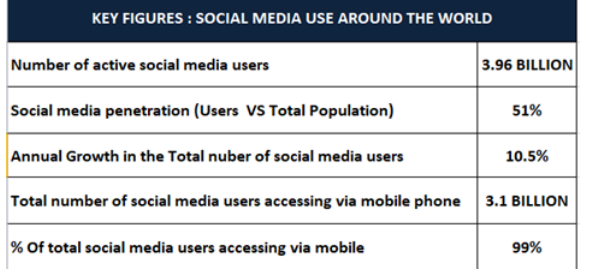
Figure 2: Social Media use around the world. Source: Compiled by us based on figures provided by world-